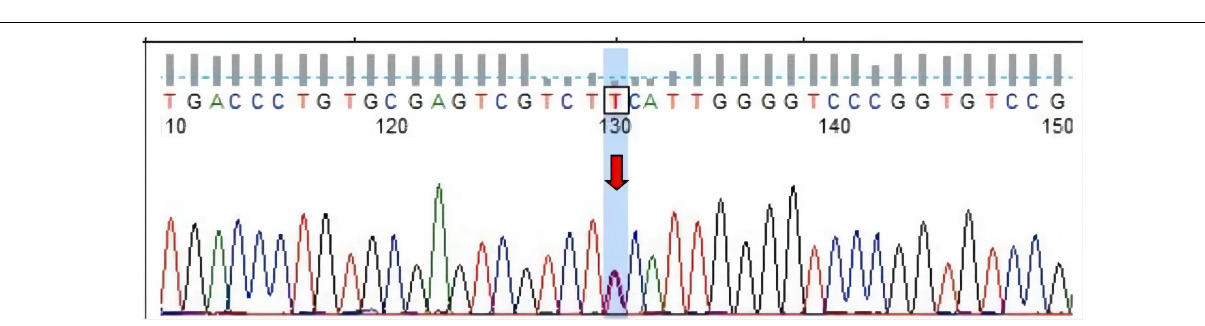
bilateral claw foot, decreased muscle strength in foot dorsiflexion (4/5), and no tendon reflex. Brain CT revealed suspected low-density foci in the corpus callosum. MRI revealed more obvious abnormal signals in the bilateral centrum semiovale ( Figure 1E ), corona radiata ( Figures 1F,G ), and corpus callosum ( Figure 1H ) when compared to his previous MRI. Brain magnetic resonance angiography showed no obvious abnormalities. Needle electromyography and NCV studies showed motor and sensory